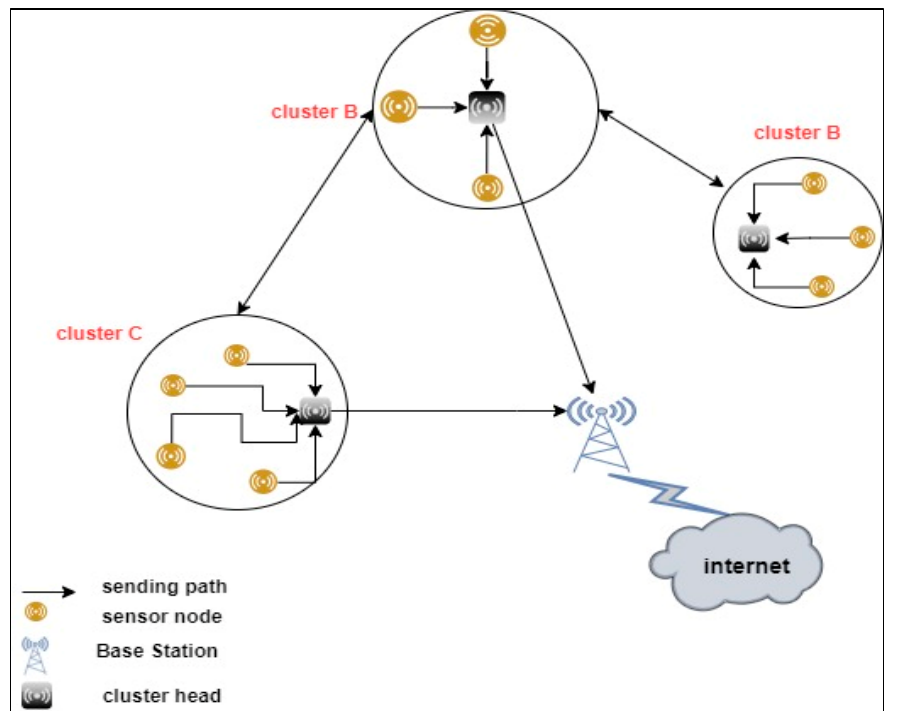
Figure 5. Indirect/multi-level communication in WSN.